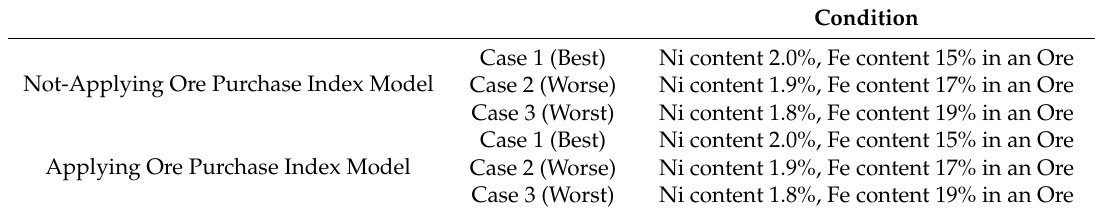
Table 3. With and without ore purchase index model LCCA: best, worse, and worst